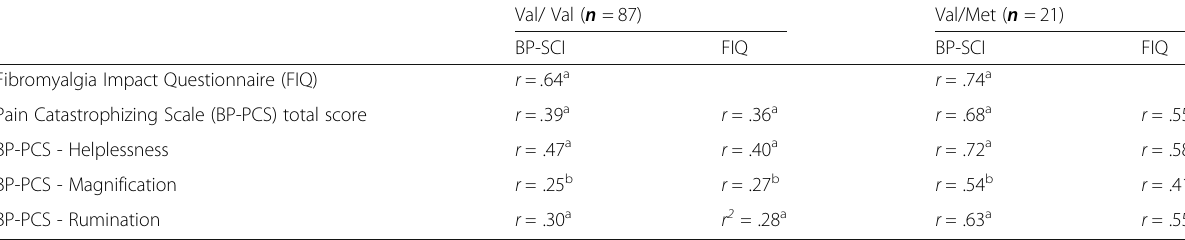
Table 3 - Correlation between pain catastrophizing, central sensitization and impact of fibromyalgia according to genotype (n = 108) Val/ Val ( n =